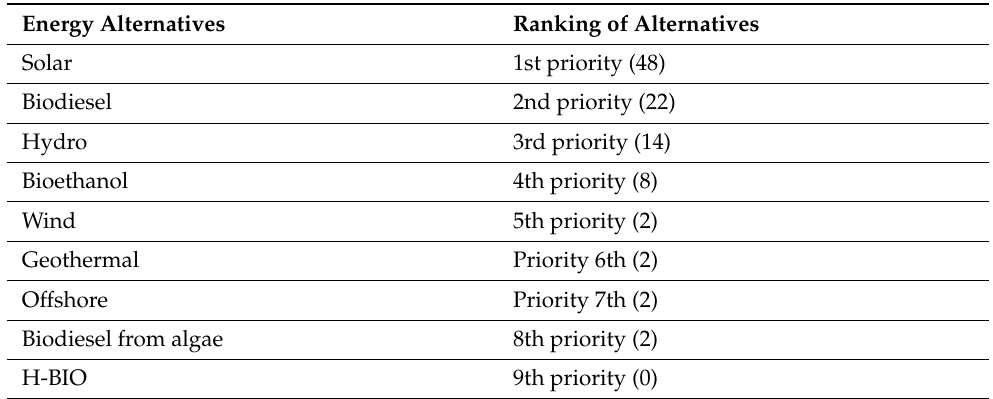
Table 13. The best alternatives to oil to be explored in